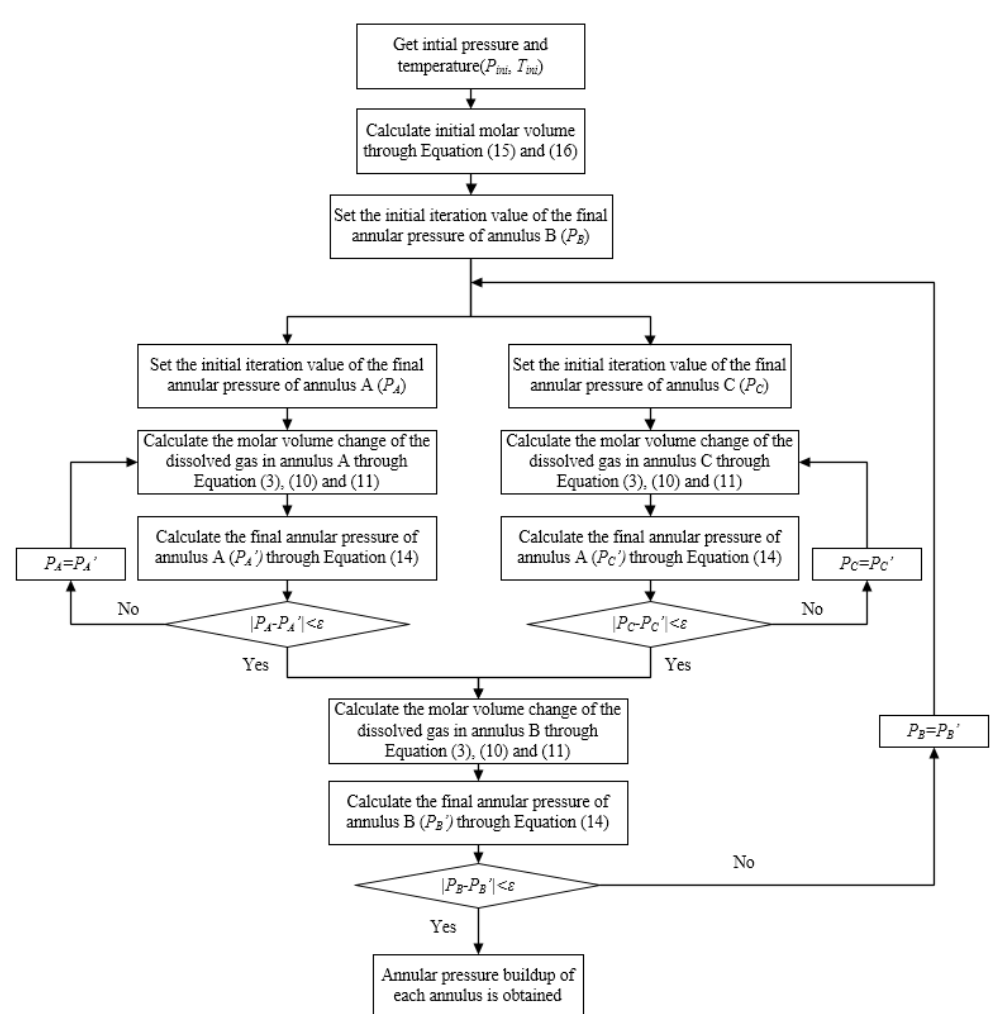
Figure 10. The calculation process of the dissolved gas model.